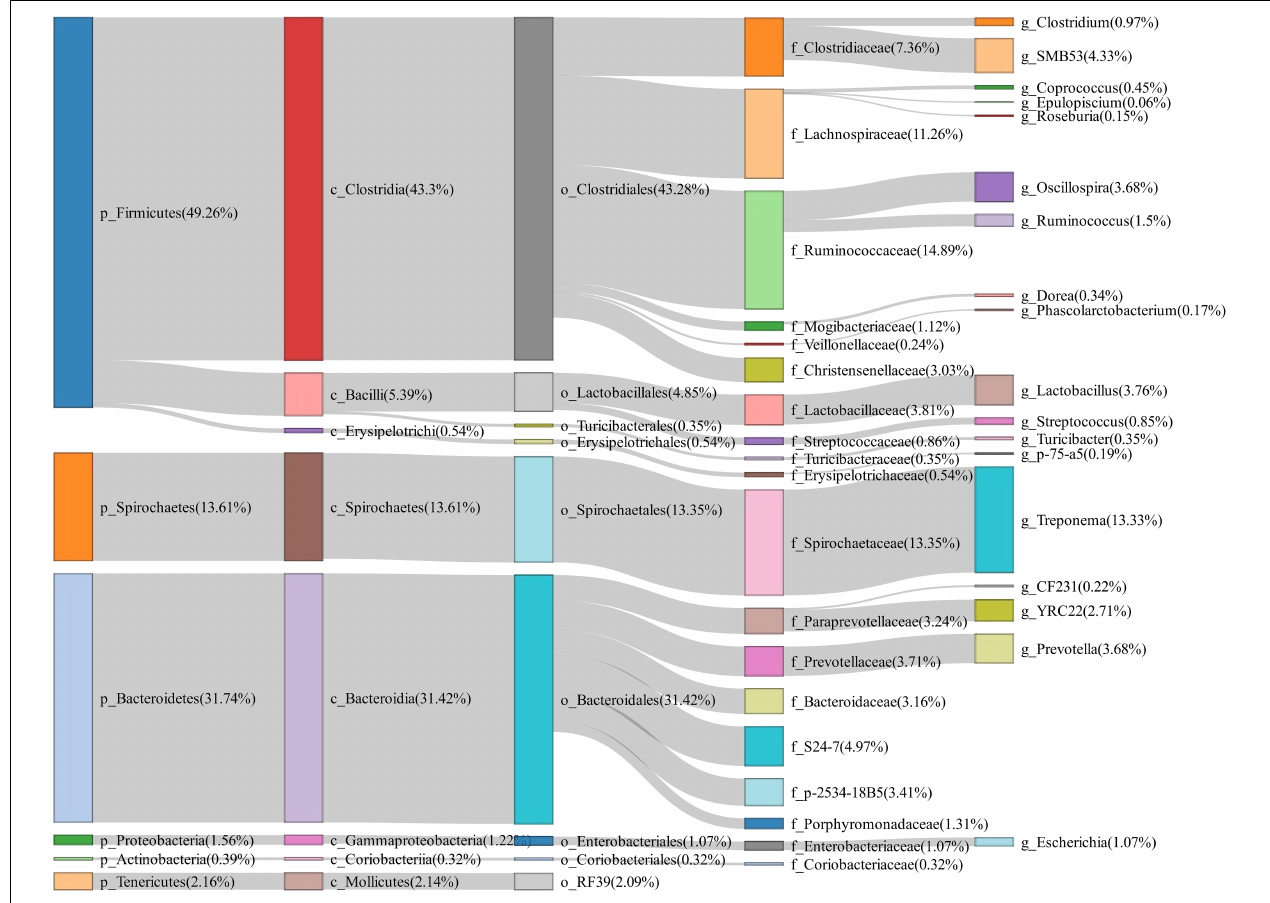
FIGURE 1 | Sankey diagram showing the bacterial composition of feces samples from experimental sows. The colored columns from left to right represent the proportions of bacterial taxa from phylum to genus